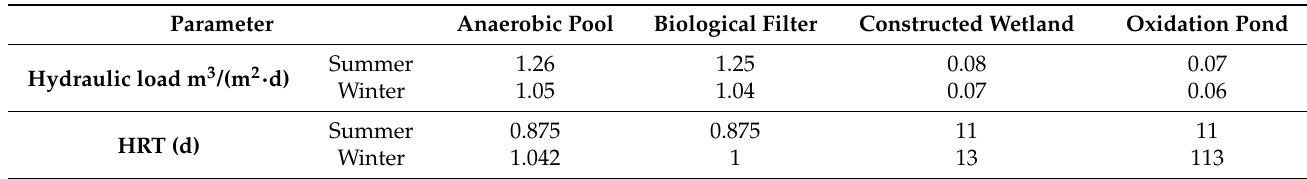
Table 2. Hydraulic load and fixed hydraulic residence time of each unit.